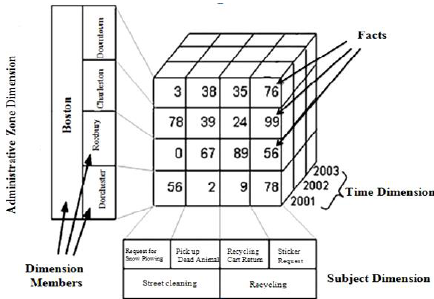
Figure 1 . One example of data cube (Rivest et al., 2005)